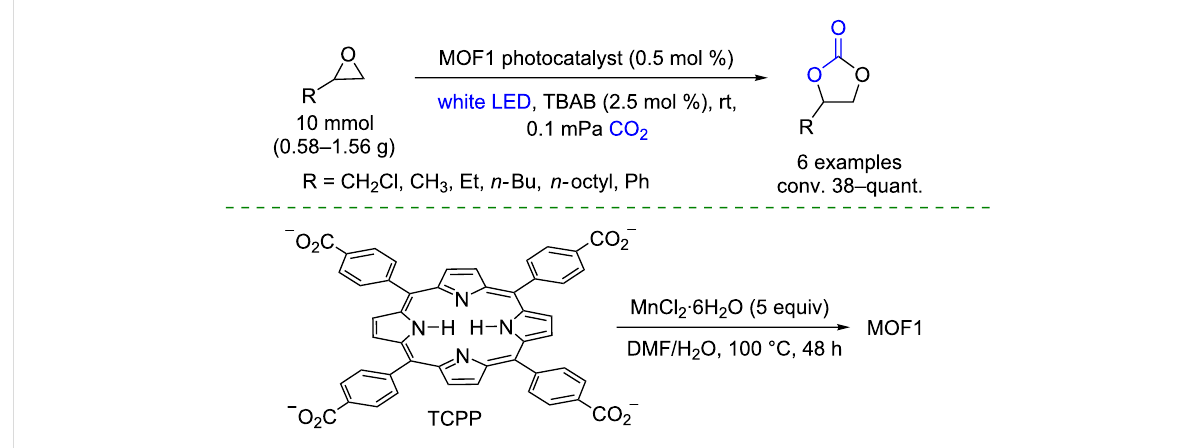
Scheme 25: Photoinduced cycloadditions of CO 2 with epoxides by MOF1.